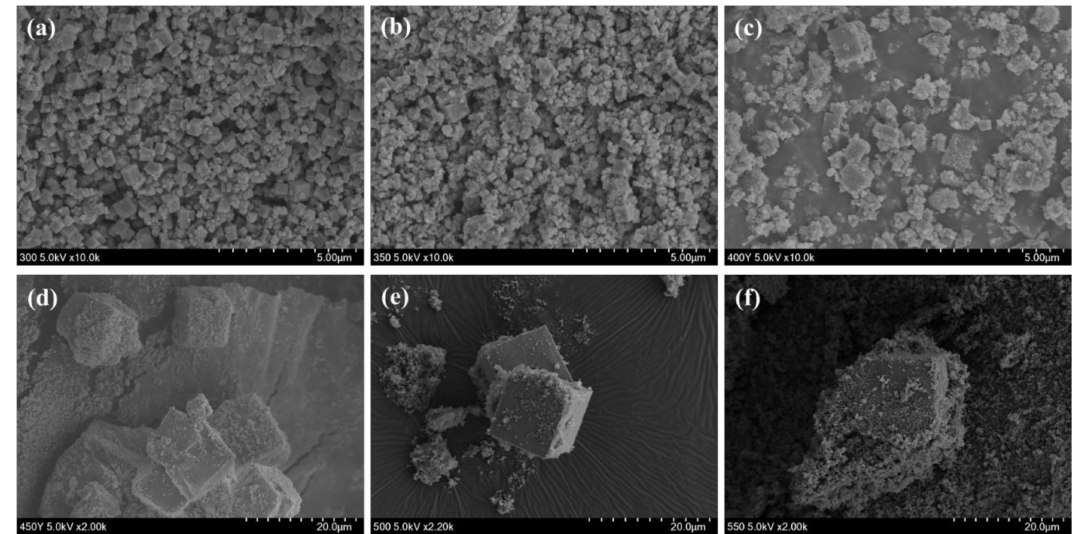
Figure 2. SEM images of the prepared TiOF 2 at various reaction temperatures; ( a ) 300 ◦ C, ( b ) 350 ◦ C, ( c ) 400 ◦ C, ( d ) 450 ◦ C, ( e ) 500 ◦ C and ( f ) 550 ◦